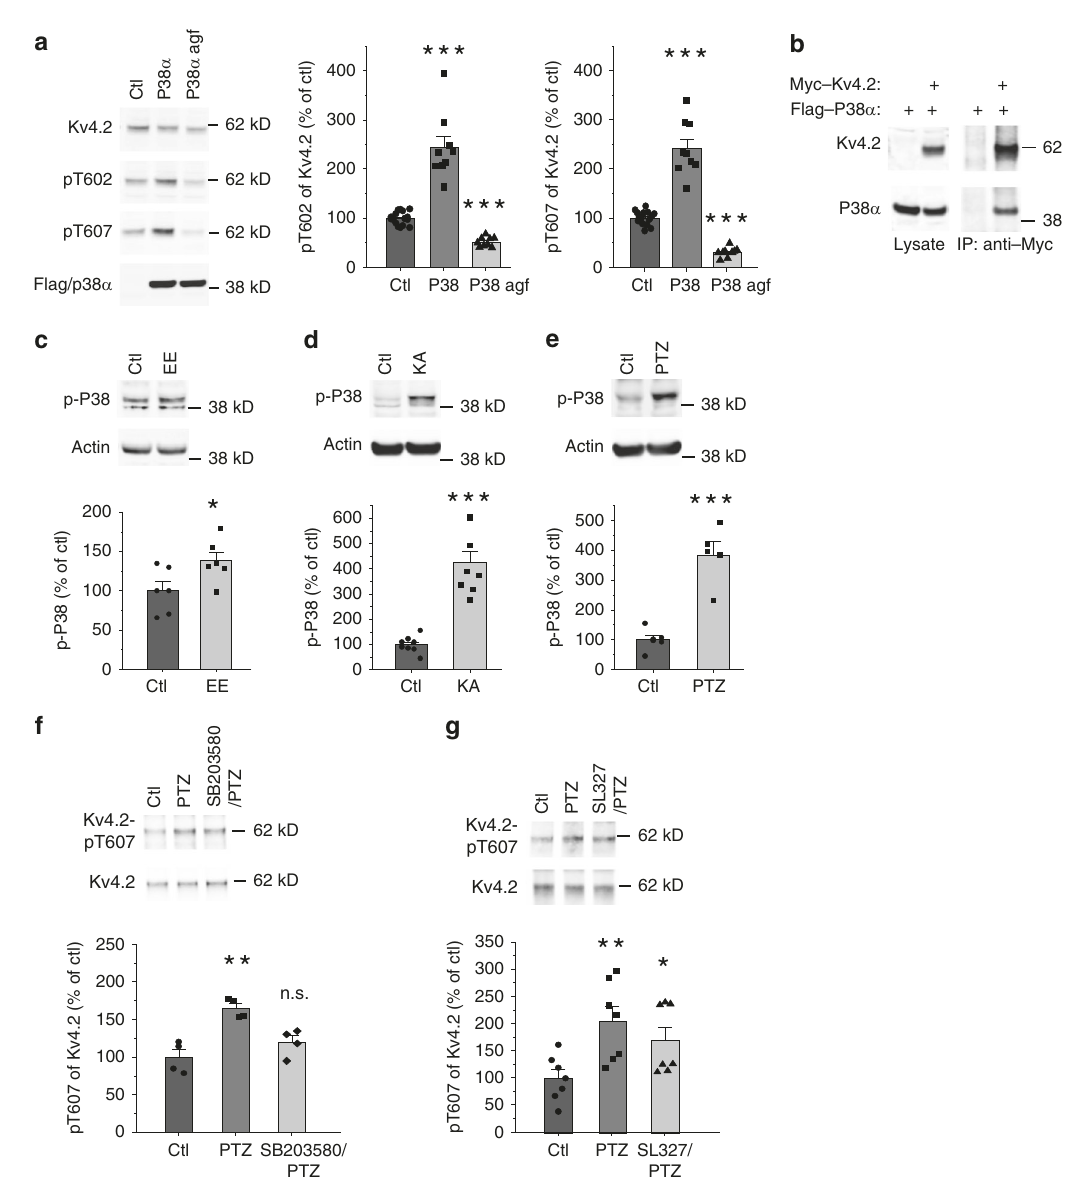
Fig. 3 P38 phosphorylates Kv4.2 at a C-terminal Pin1 binding site. a P38 phosphorylates Kv4.2 at Thr602 and Thr607. Kv4.2 and p38 α constructs (agf: p38 kinase dead mutant) were co-transfected into HEK-293T cells. Lysates were analyzed by western blotting with anti-pT602 and anti-pT607 speci fi c antibodies. n = 15 for ctl, 9 for p38 and p38 agf. T -test, *** p < 0.001. b p38 binds to Kv4.2. Kv4.2 and p38 α were co-transfected into HEK-293T cells. Detergent lysates were incubated with anti-Myc antibody and analyzed by western blotting with anti-Flag and anti-Myc antibodies. Data was repeated in two independent experiments. c , Enriched novel environment activates p38 in mouse hippocampus. n = 6 in each group. T -test, * p < 0.05. d